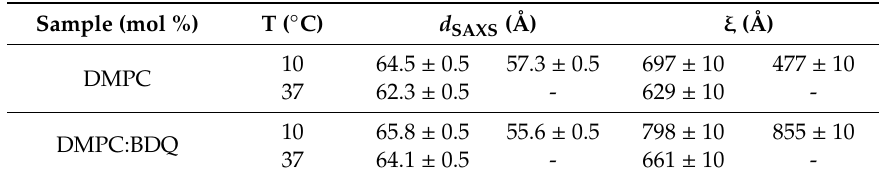
Table 1. Small-angle X-ray scattering (SAXS) di ff raction profiles of 1,2-dimyristoyl- rac